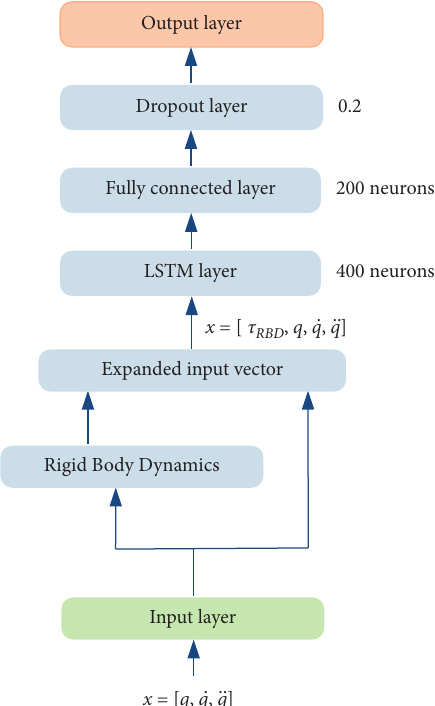
Figure 3: Proposed deep learning architecture.